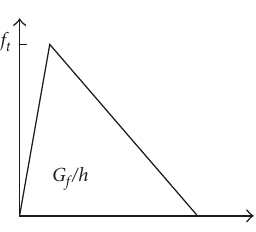
Figure 10: Tensile model with linearized